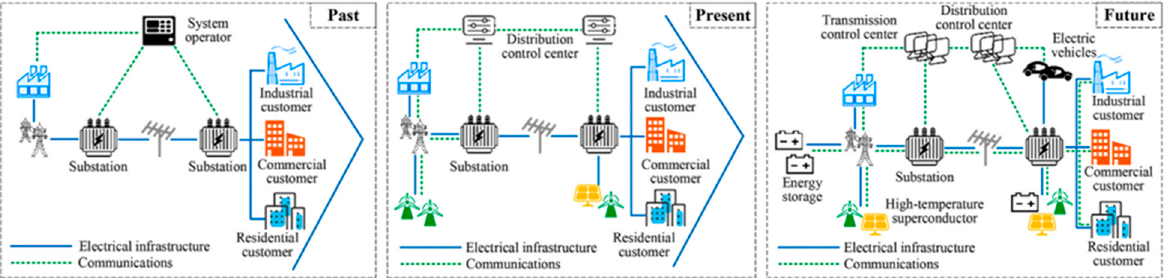
Figure 1. Evolution of electrical grids—from traditional grids to smart grids [2].